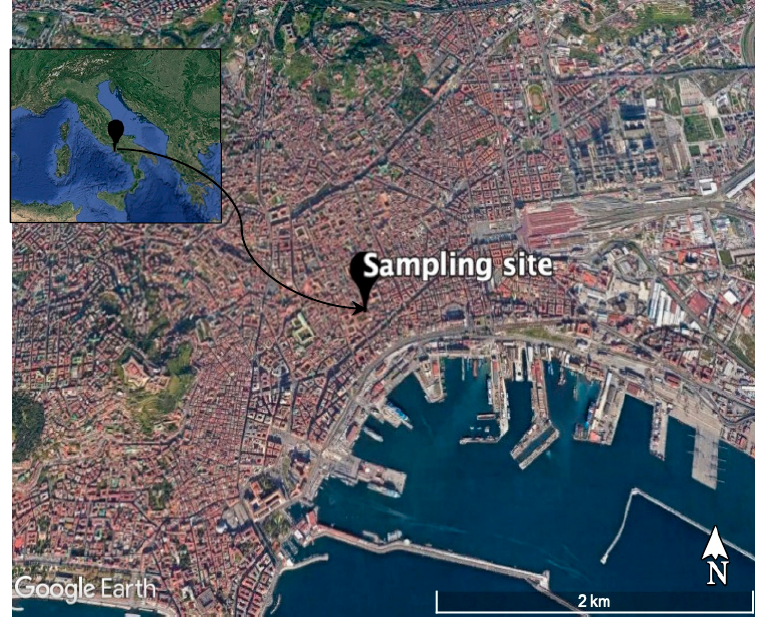
Figure 1. Location of the sampling site in Naples (Italy).